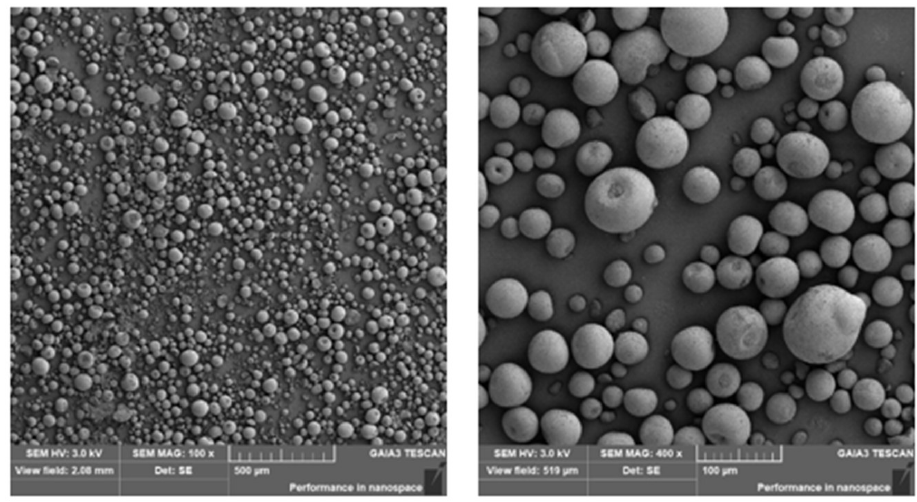
Figure 6. SEM images of spray dried alumina powder [29] (republished based on the open access permission).